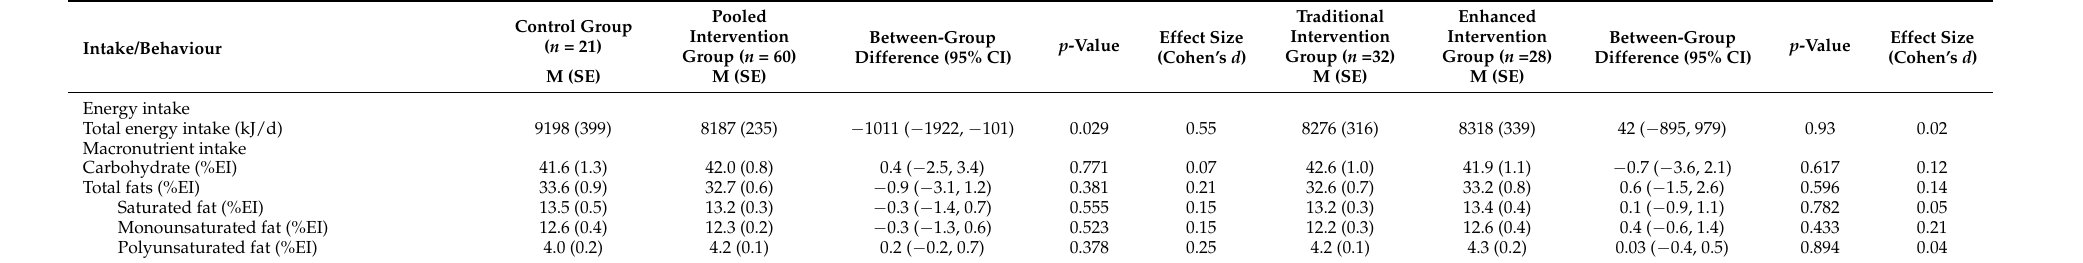
Table 2. Between-group differences in dietary intake, physical activity, and sleep health at six months ( n =